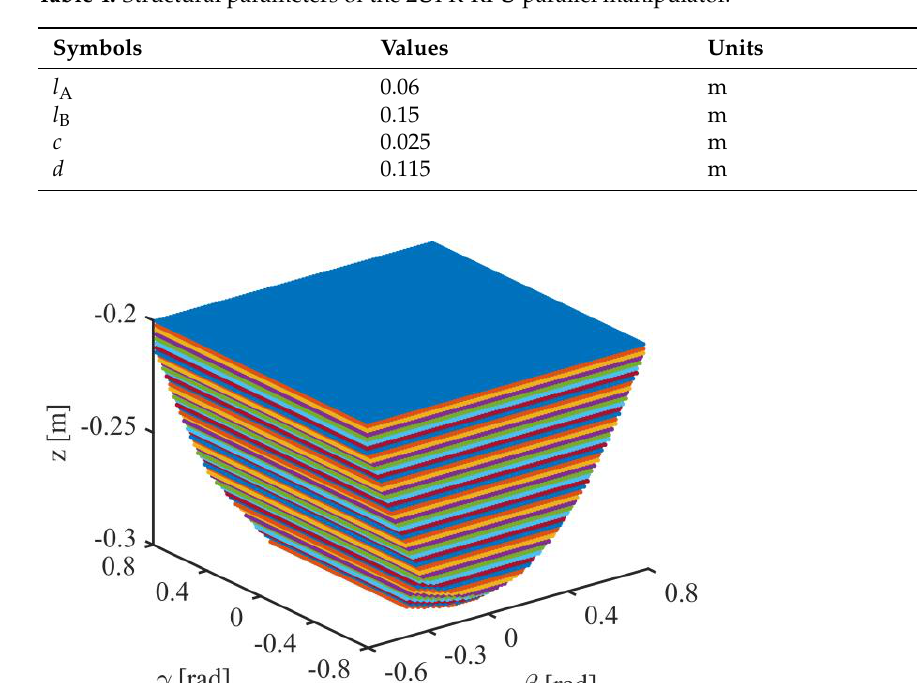
Figure 4. Reachable workspace of the 2UPR-RPU parallel manipulator.